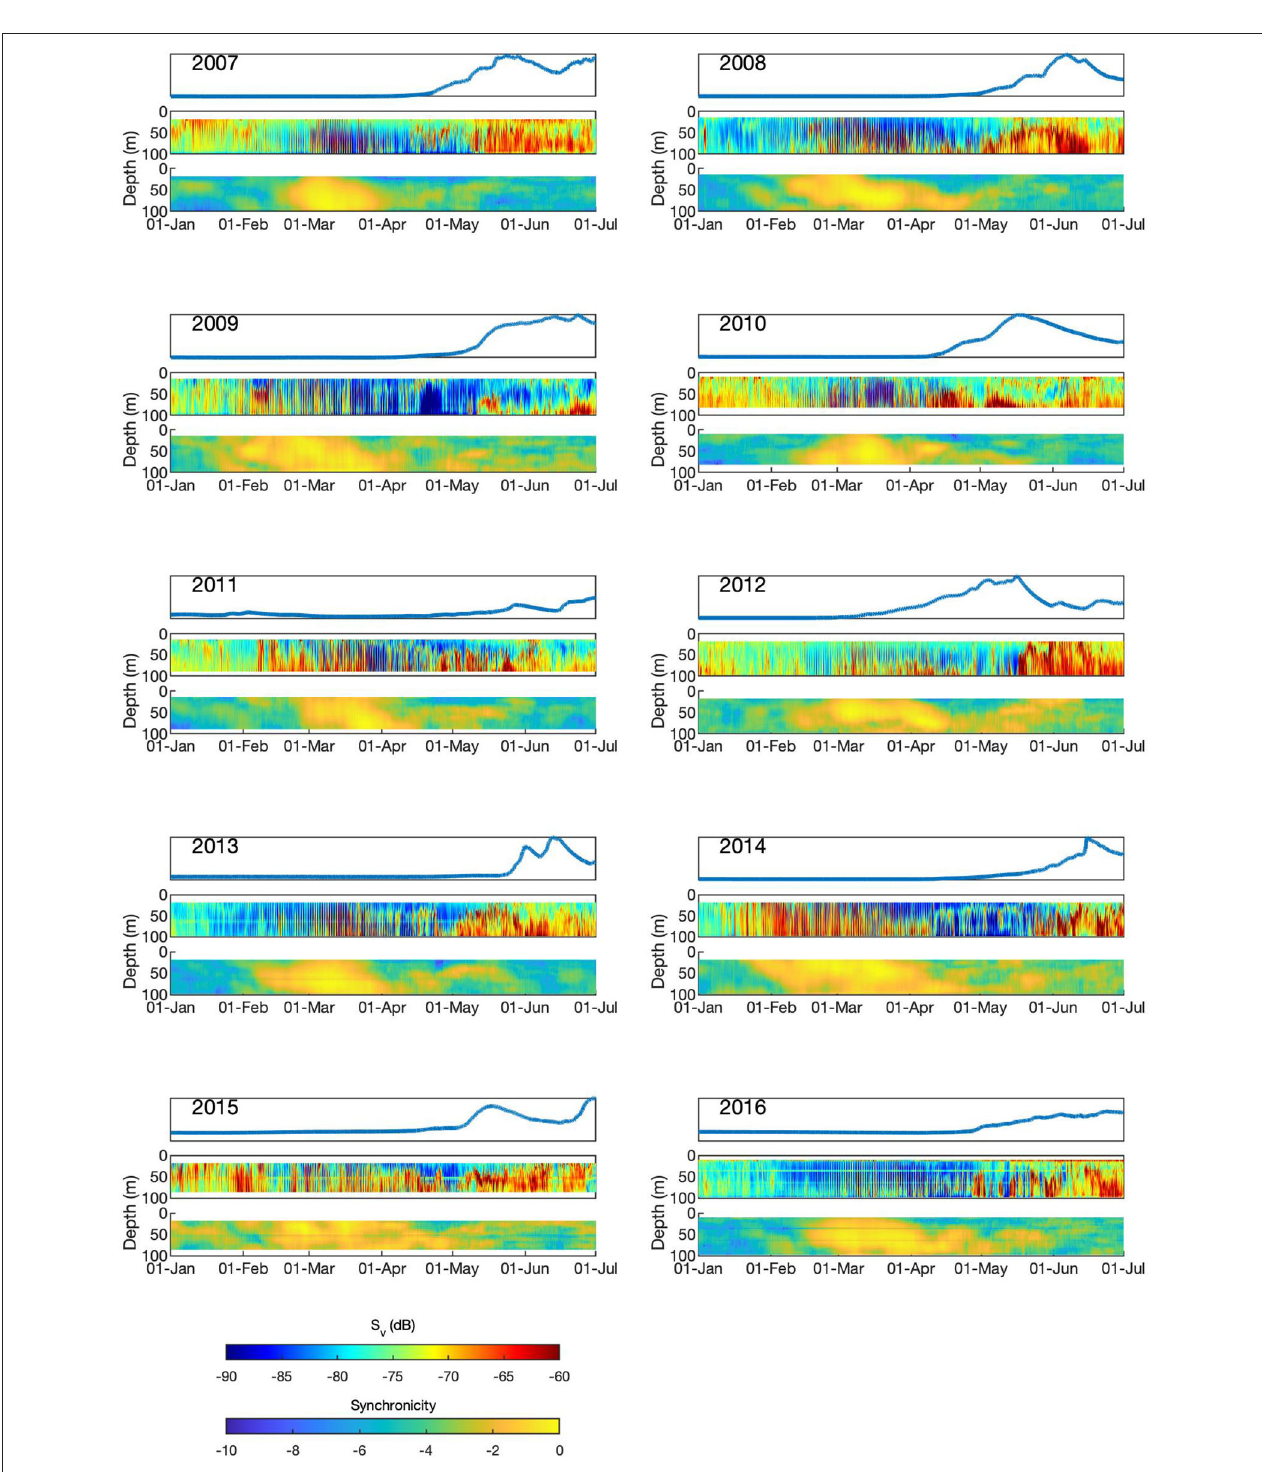
FIGURE 6 | Fluorescence and zooplankton dynamics in Kongsfjorden, January-June in the years 2007–2016. Each year comprises three plots showing data for (from top to bottom ): normalized chl-a fluorescence; ADCP backscatter ( S v , dB); synchronicity (log scale of power spectral density). able to survive when exiting diapause after the date of the peak secondary region of high fitness (in addition to the continued in spring bloom biomass occurs (indicated in regions to the right area of high fitness associated with September entry and exit just of the dotted line in cases of P win ≥ 20 µ g C L − 1 ), but values of before the spring bloom). As P win increases, copepods are also